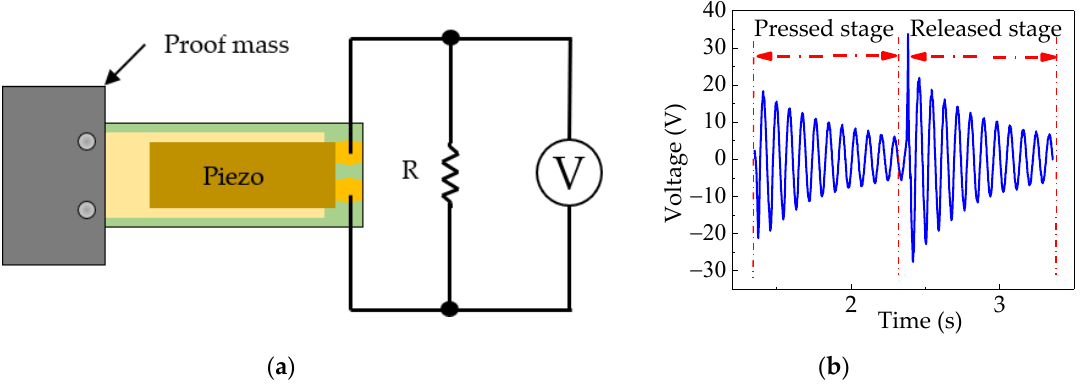
Figure 2. ( a ) Measurement setup of PEH, and ( b ) typical output voltage of PEH test bench.